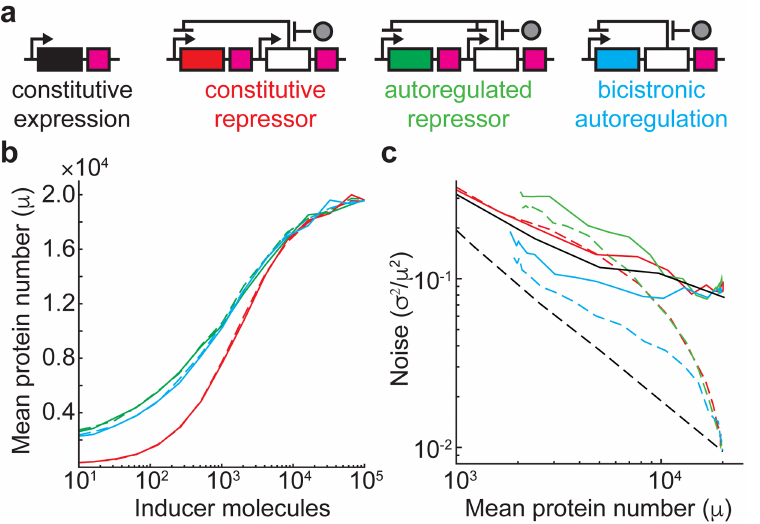
Fig 1. Simulated gene expression dose-response and noise in different regulatory circuits. ( A ) Schematics of the regulatoryschemes explored by stochastic simulation. Genes of interest (includingcoding sequenceand translation start/stop signals)are shown as rectanglescolored black (constitutive expression), red (repressedby a constitutivelyexpressedtranscriptional repressor), green (repressedby an autoregulated transcriptional repressor)and blue (autoregulated, bicistronicexpression). White rectangle, transcriptional repressor. Gray circle, inducer. Black arrow, promoter. Purple square, transcription terminator. ( B ) Response to inducerfor all regulated networks in the absence(dashedlines)and presence (solid lines)of extrinsic noise. Lines are colored accordingto the gene colors in Fig 1A . ( c ) Dependence of geneexpressionnoise on averageexpression. Line style same as in Fig 1B